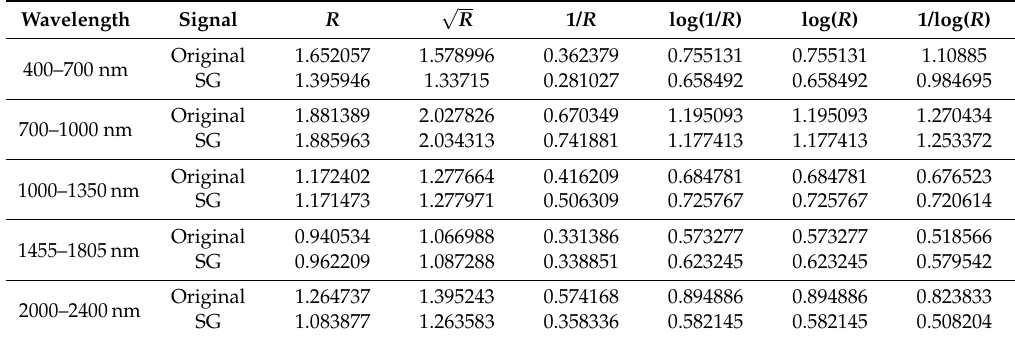
Table 4. The RMSE value of the PNN model in Area B.